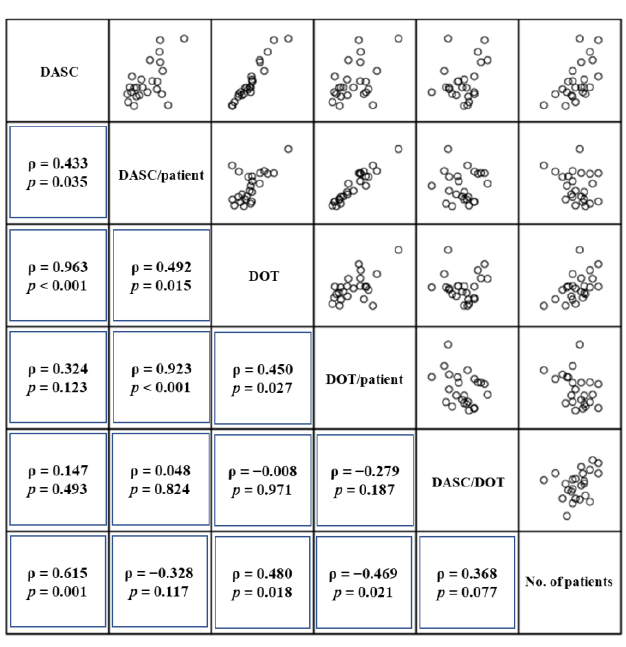
Figure 3. Monthly DASC/DOT trend during this 2-year period. DASC, days of antibiotic spectrum coverage; DOT, days of therapy.